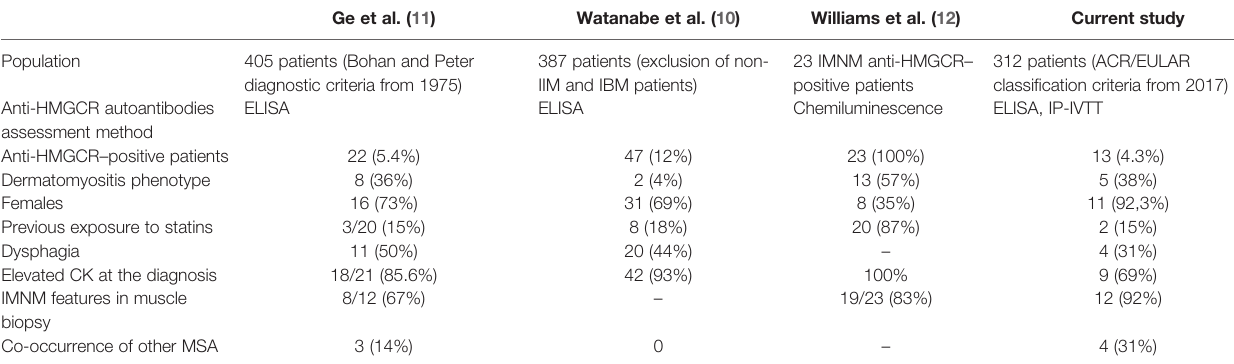
TABLE 4 | Comparison of studies screening large IIM cohorts for anti-HMGCR autoantibodies. Ge et al.